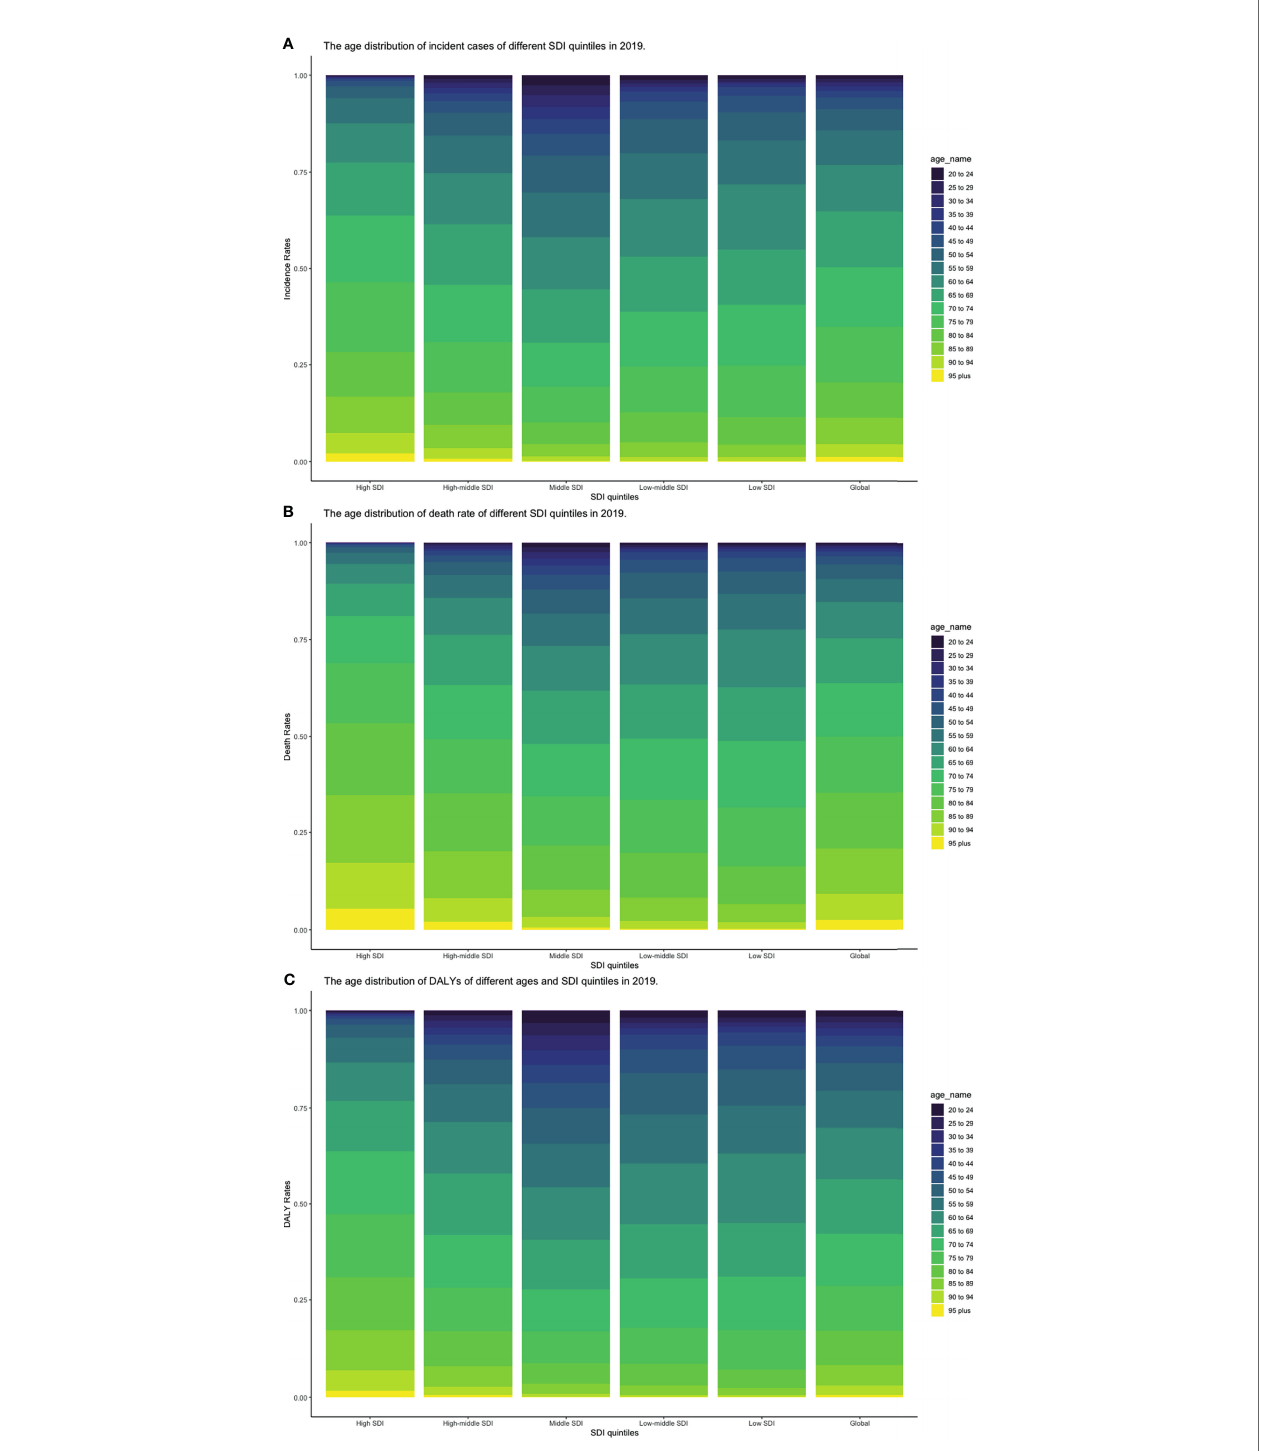
FIGURE 8 | Proportion of age groups on (A) incident cases, (B) death cases, and (C) DALYs by SDI quintiles in 2019 (DALY, disability-adjusted life year; SDI, socio- demographic